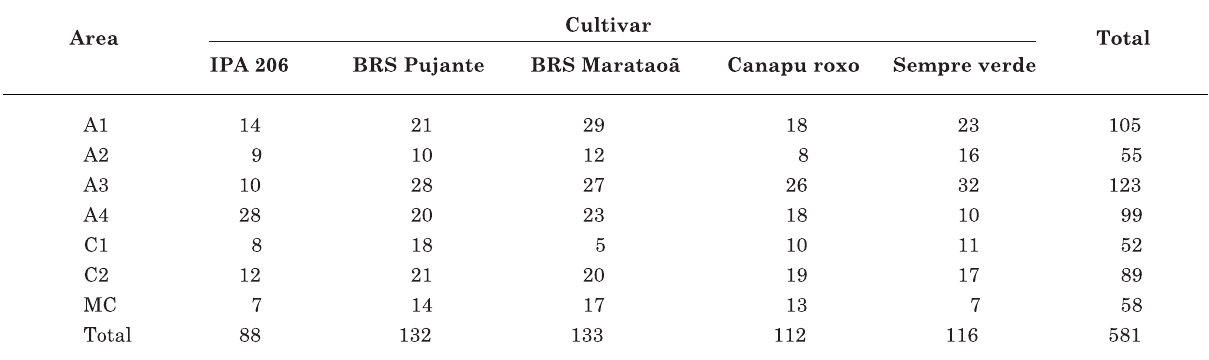
Table 4. Number of rhizobium isolates obtained from cowpea grown in soils of the lower half of the São Francisco